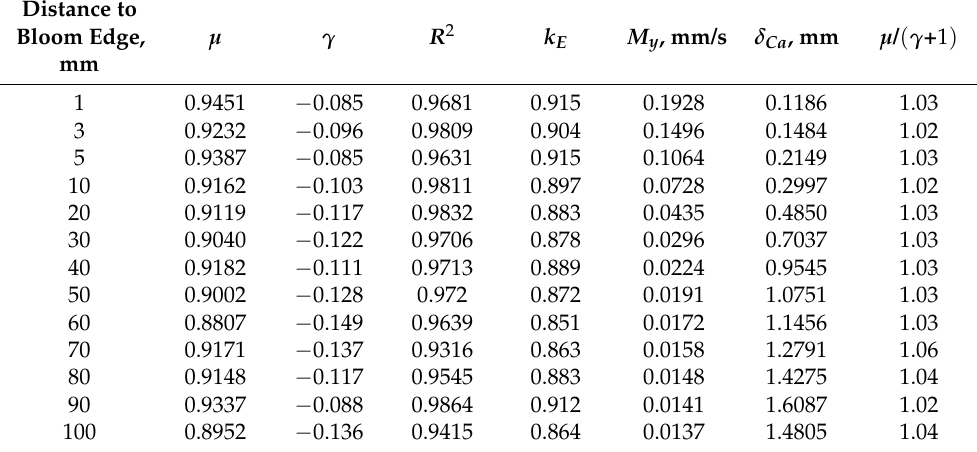
Table 5. Fitted and calculated results in the outer curve side under 35 ◦ C ( µ , γ are fitted coefficients in Equation (3), and R 2 is the corresponding determination coefficient. k E is the effective solute redistribution coefficient. M y is growth velocity magnitude in the solidification unit along the measuring line at each position. δ Ca is the average thickness of the concentration boundary layer). Distance to Bloom